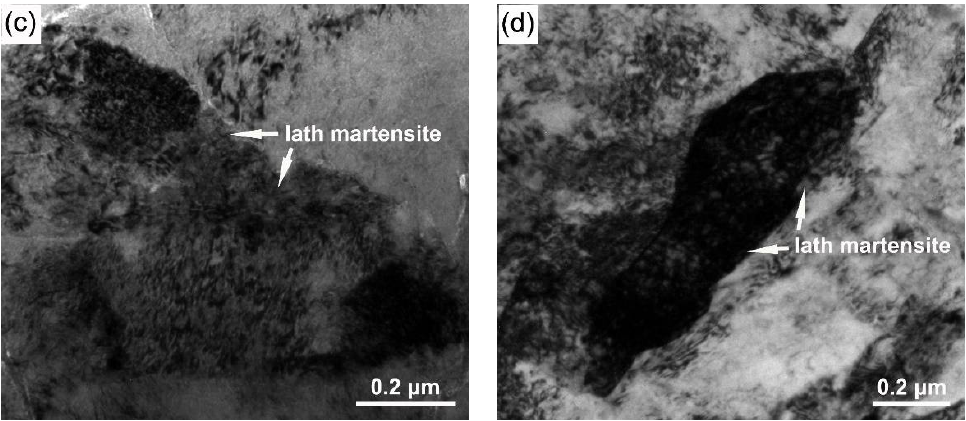
Figure 4. TEM images of M-A constituents in the IC HAZ with varying peak temperatures: ( a ) 760, ( b ) 770, ( c ) 800, and ( d ) 860 °C.